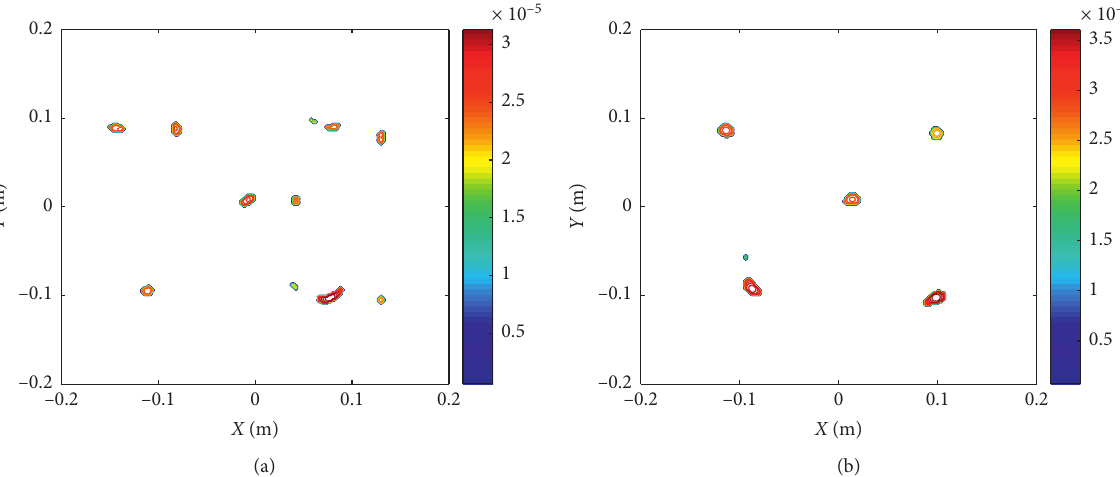
Figure 16: Comparison of missing data in OMP imaging results. (a) With equally spaced approximate parameters. (b) With estimated